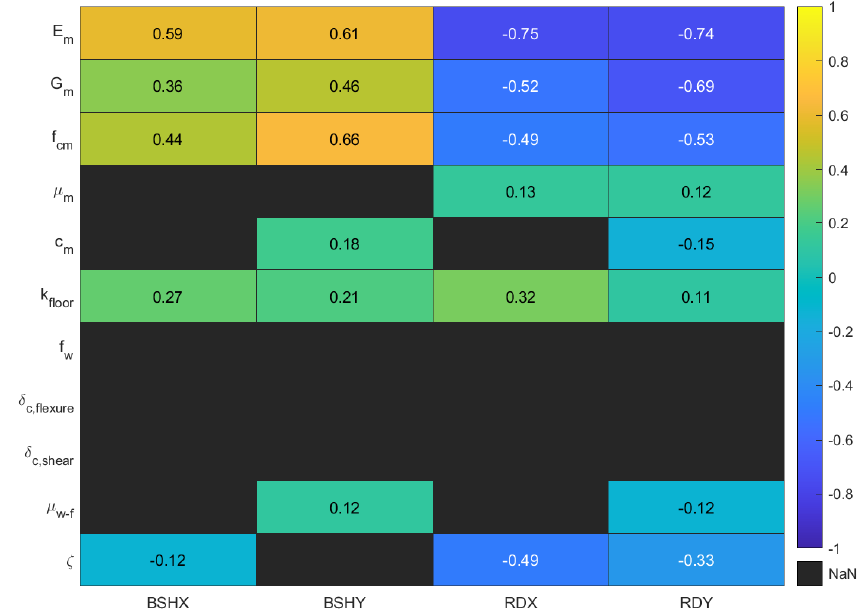
Figure 17. Lausanne Malley model Spearman correlation matrix for PGA 0.105